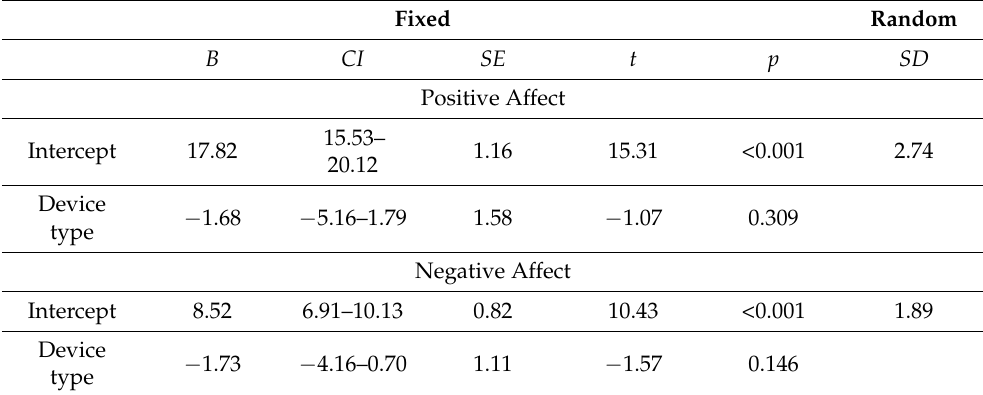
Table 3. Results of multi-level models of positive and negative affect. Fixed